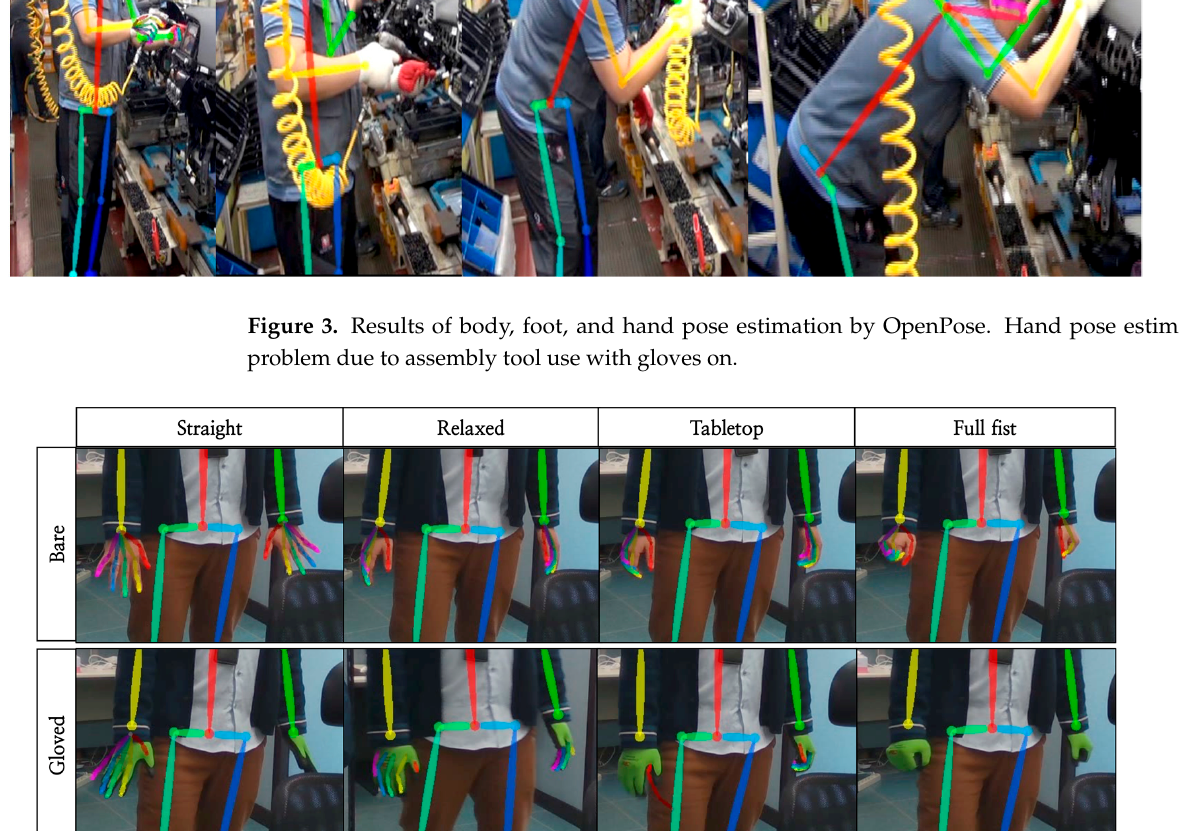
Figure 4. Comparison of OpenPose estimation results based on hand posture for bare and gloved hands. We also examined the images of workers captured at the automobile cockpit mod- ule manufacturing process site and found that all workers were wearing gloves and in some cases aprons or sleeve protectors, depending on the process. In a manufacturing environment where wearing personal protective gear is unavoidable for the safety of workers depending on the characteristics of the workplace, it is essential to estimate the